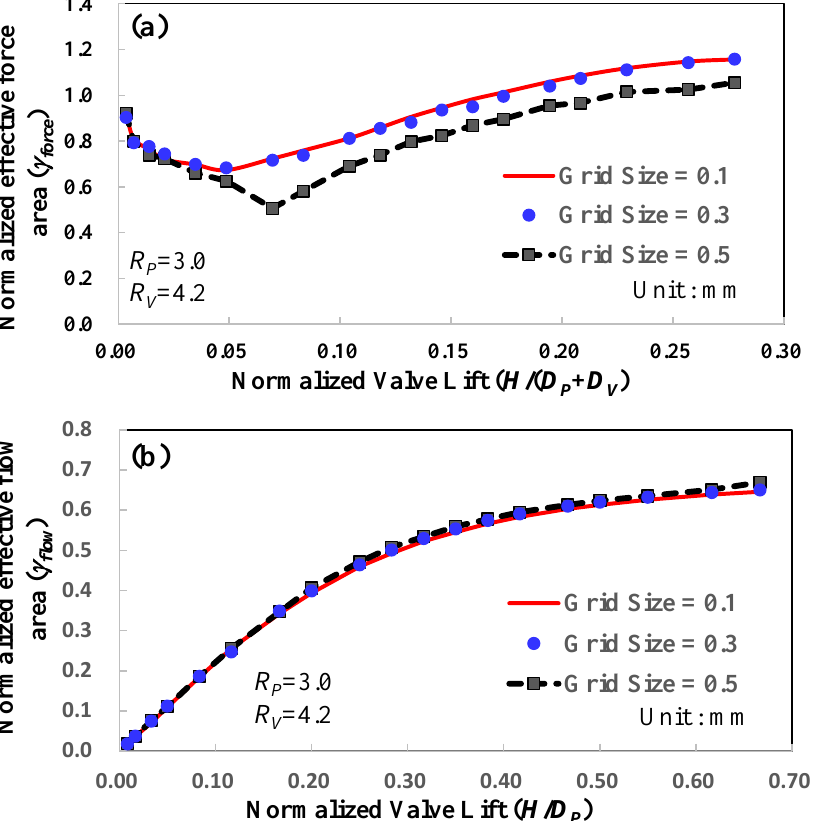
Figure 3. Normalized ( a ) effective force area; and ( b ) effective flow area for three cases of grid size.